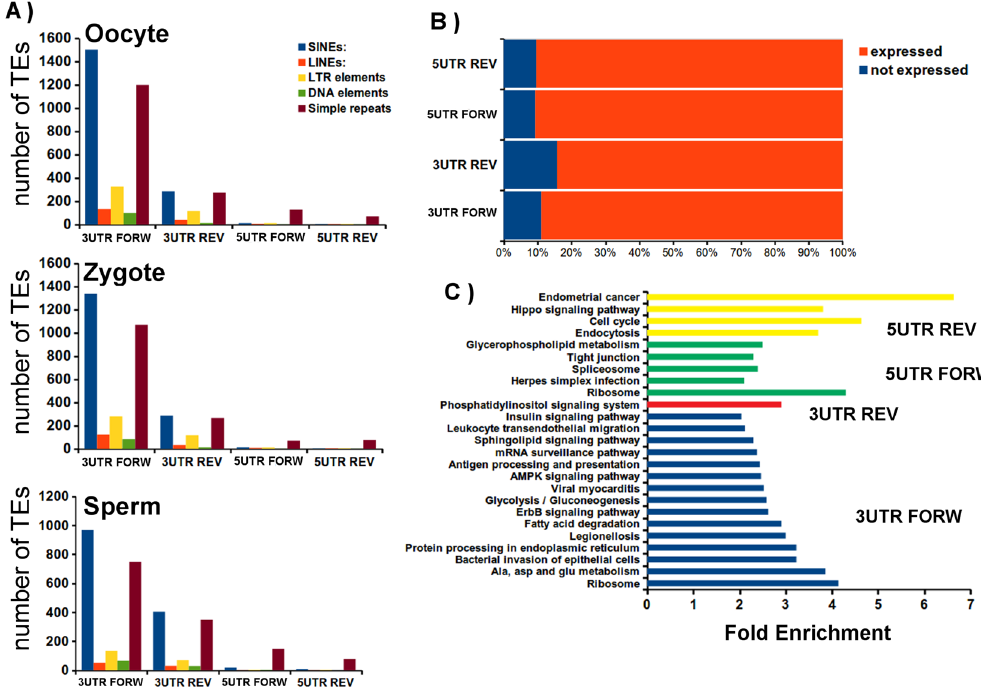
Figure 7. Analysis of the UTRs regions with associated RapiRNAs. Number of sequences of TEs and simple repeat found in UTRs sequences associated with RapiRNAs. ( B ) Graph represents the percentages of expressed/ non-expressed genes and the UTRs regions with RapiRNAs-associated, ( C ) KEGG enriched analysis of genes expressed with RapiRNA-associated UTRs in